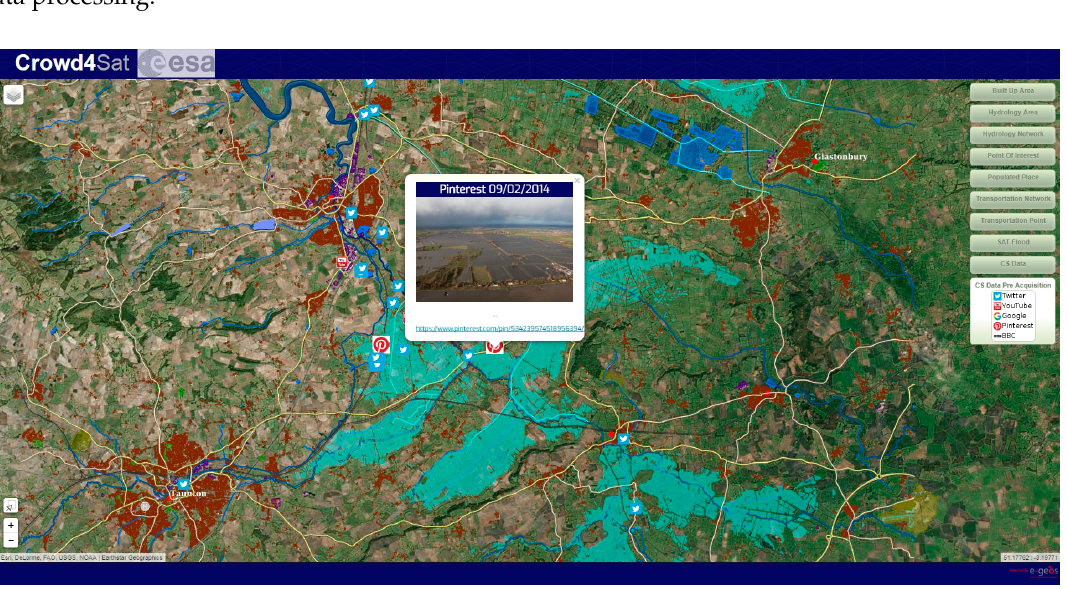
Figure 5. Example of a WebGIS interface showing geolocated social media data overlaid on the flood extent of the UK floods in 2014 (The activity was carried out under a programme of, and funded by, the European Space Agency) [105].